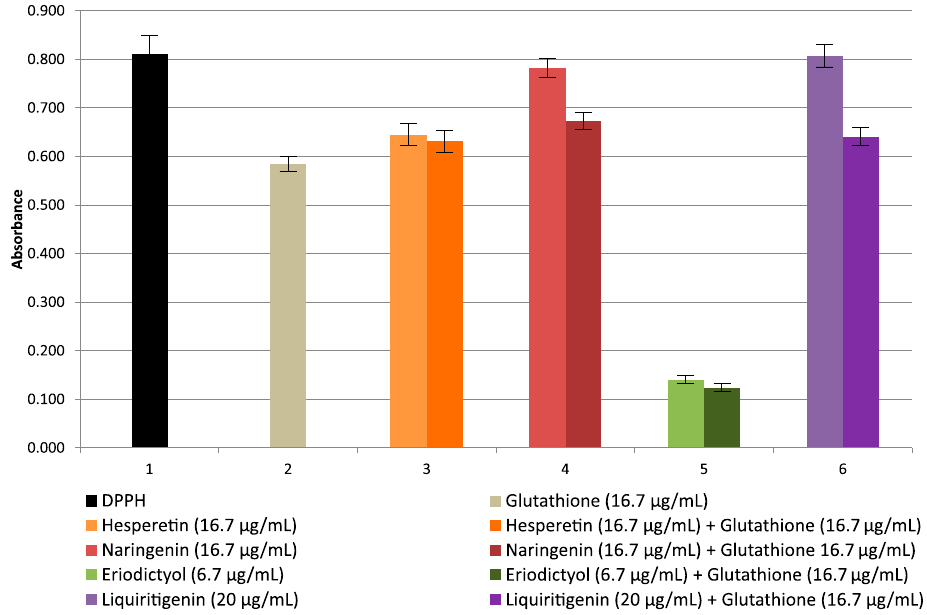
Figure 5. Changes in absorbance of glutathione (16.7 μ g/mL), flavanones (hesperetin, naringenin 16.7 μ g/mL; eriodictyol 6.7 μ g/mL; liquiritigenin 20 μ g/mL) and mixtures of individual flavanones with glutathione.